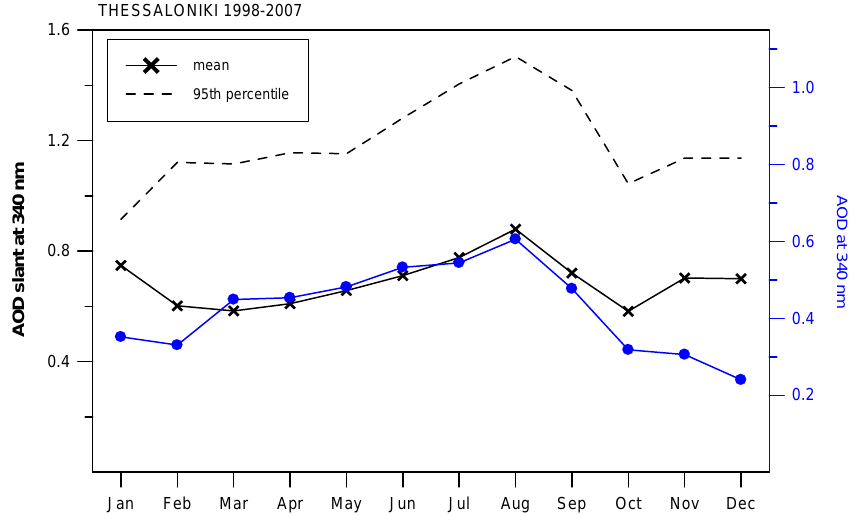
Figure 2. Mean AOD (blue) and AODs (black line and symbols) values at 340 nm Fig. 2. Mean AOD (blue) and AODs (black line and symbols) values at 340nm measured from 1998–2006 at Thessaloniki. The 95th percentile values of the mean AODs are also measured from 1998-2006 at Thessaloniki. The 95 th percentile values of the mean AODs are also shown.